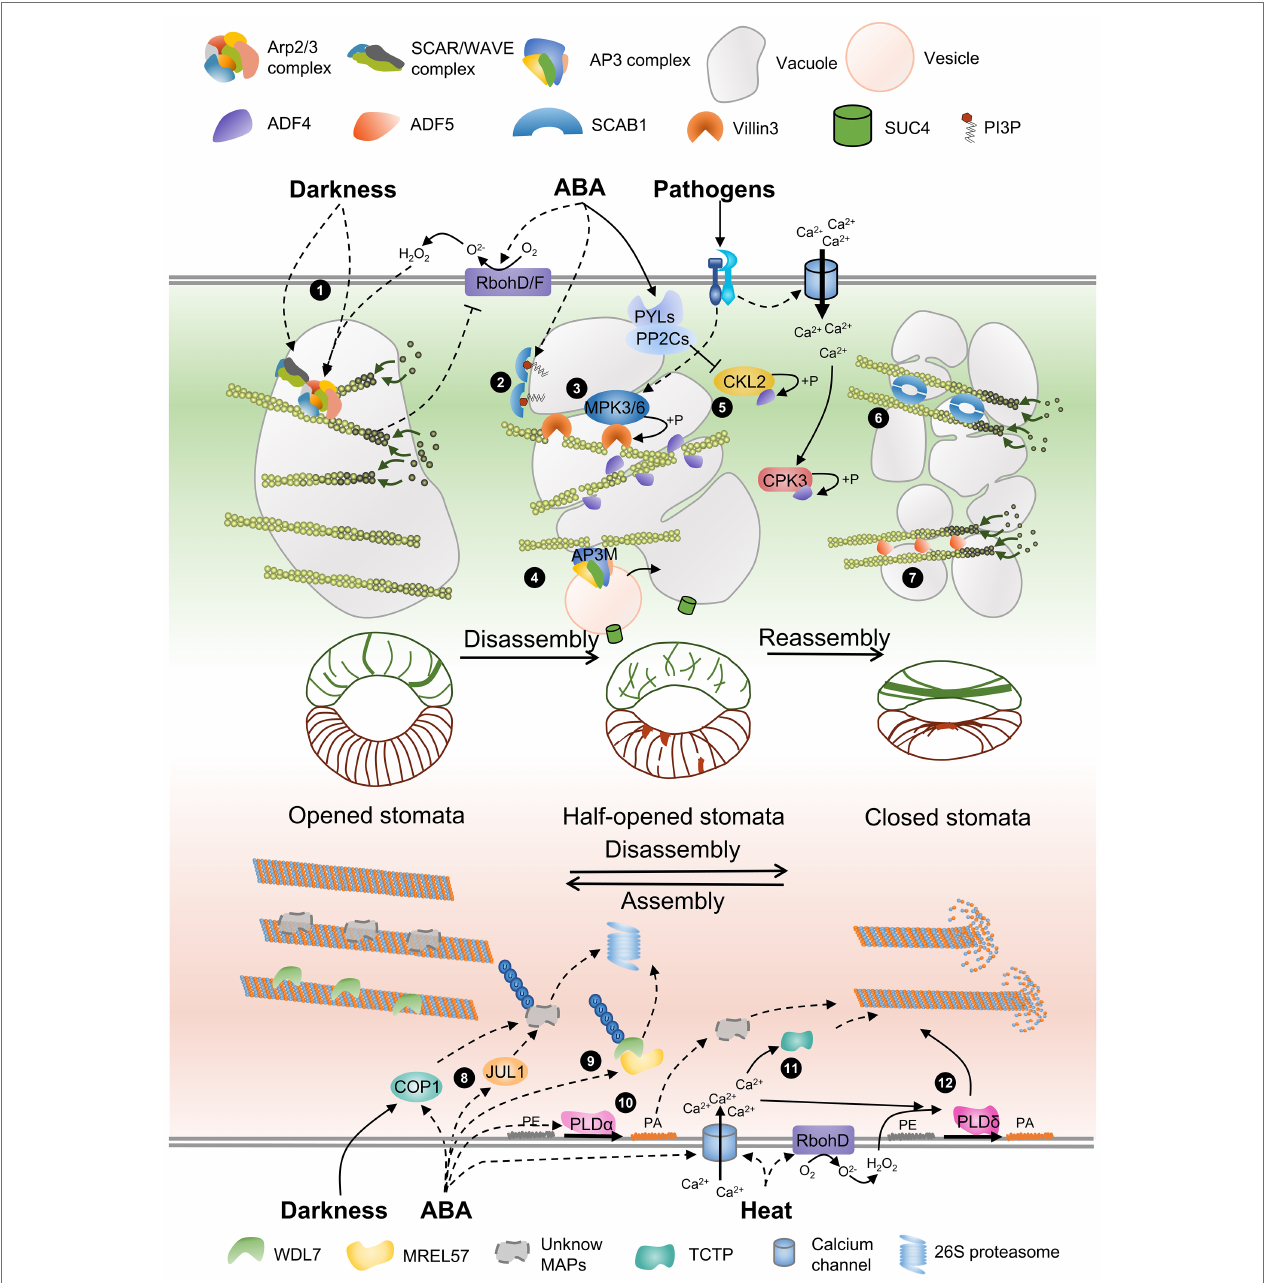
FIGURE 1 | A schematic model of AF and MT remodeling accompanied by vacuole morphology during stomatal closure. The schematic model of stomata in the middle of the panel shows the distribution of AFs and MTs in guard cells with different stomatal apertures. The gray circular charts present the different morphology of vacuole during stomata movement. Several actin-binding proteins and microtubule-associated proteins are involved in regulating cytoskeletal rearrangement. (1) The Arp2/3 complex and the activator SCAR/WAVE complex are required for AF nucleation and branching, and darkness-induced stomata closure. ABA-triggered H 2 O 2 generation by RbohD/RbohF regulates AF dynamics through the Arp2/3 complex but does not regulate the SCAR/WAVE complex, and AF feedback regulates H 2 O 2 production. (2) ABA-triggered PI3P biosynthesis inhibits the oligomerization of SCAB1. (3) A pathogen triggers MPK3/MPK6 activation, and Villin3 is then phosphorylated to increase AF-severing activity. (4) AP3M of the AP3 complex severs AFs and regulates vesicles from Golgi carrying SUC4 fused to the tonoplast. (5) ADF4 binds to and severs AFs, and ABA-activated CKL2 and calcium-activated CPK32 induced by pathogens phosphorylate ADF4 to inhibit its activity and promote AF reorganization. (6 and 7) SCAB1 dimers and ADF5 monomers bundle and stabilize AFs and promote AF reassembly. (8) JUL1 and COP1, two other E3 ubiquitin ligases, may control the degradation of unknown MT-stabilizing factors and promote MT disassembly. (9) WDL7 stabilizes MTs in open stomata. The E3 ubiquitin ligase MREL57 interacts with and ubiquitinates WDL7 for 26S proteasome degradation during ABA-induced stomatal closure. (10) ABA-triggered